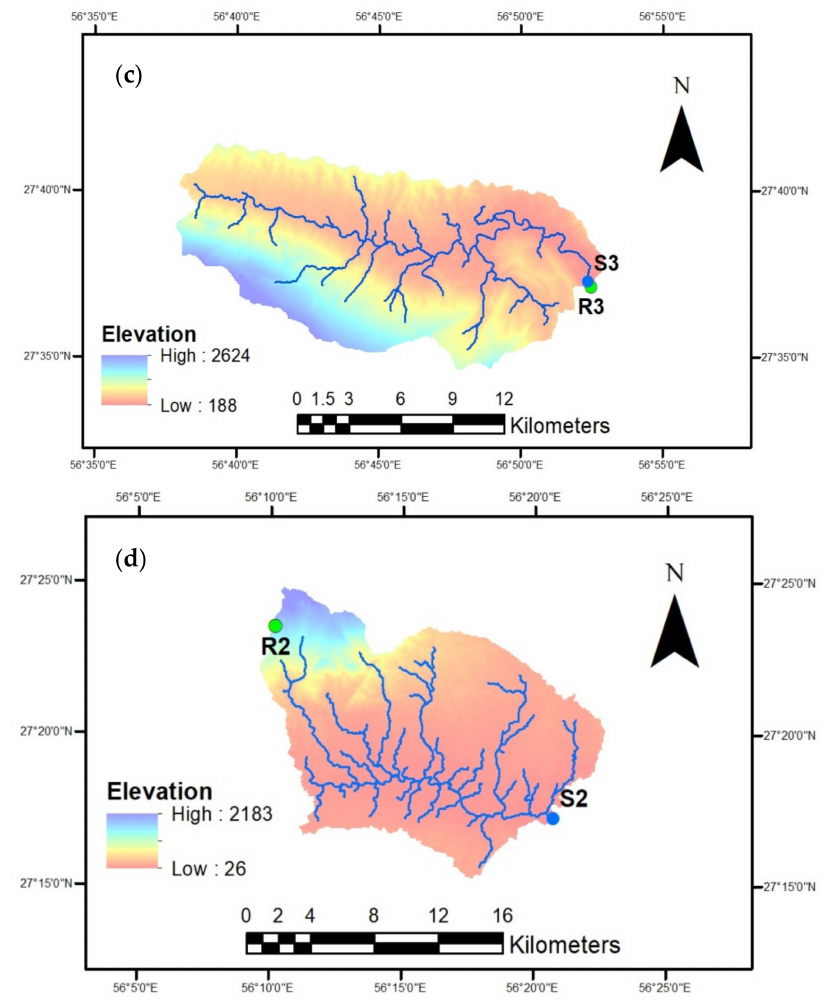
Figure 4. Studied sub-watersheds: ( a ) Shaghrud, ( b ) Sikhoran, ( c ) Salublm, ( d ) Chahchakur (R1, R2, R3, R4) rainfall stations (S1, S2, S3, S4) runoff